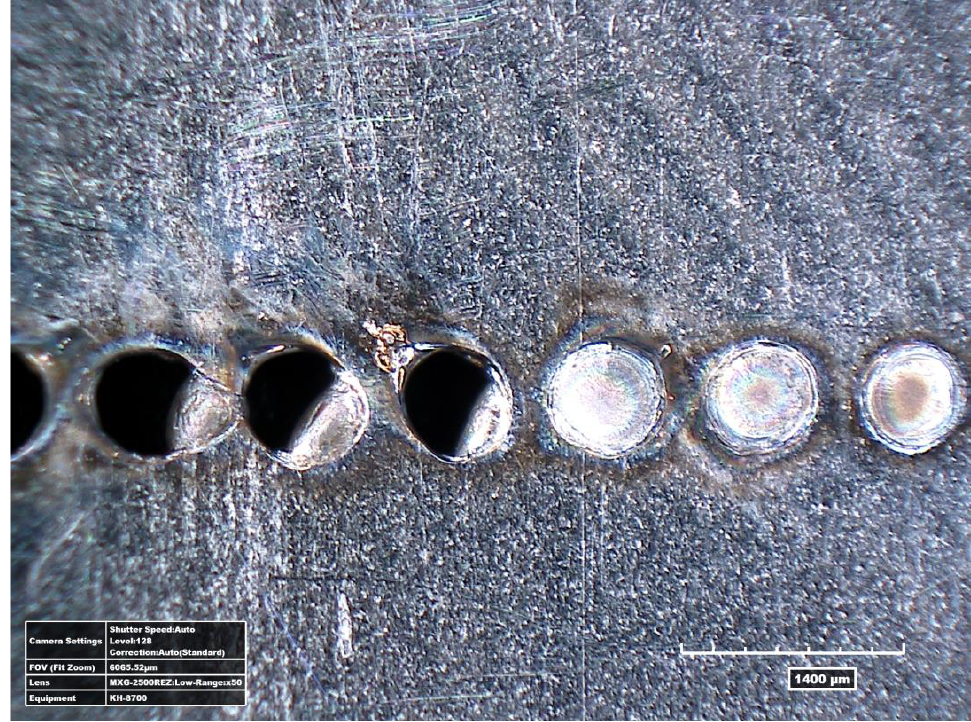
Figure 5: Selection of welding parameters for joining nickel foil and 0H18N9 steel foil. Face view for the following pulse lengths (from left to right): 7ms, 6 ms, 5ms, 4ms, 3ms and